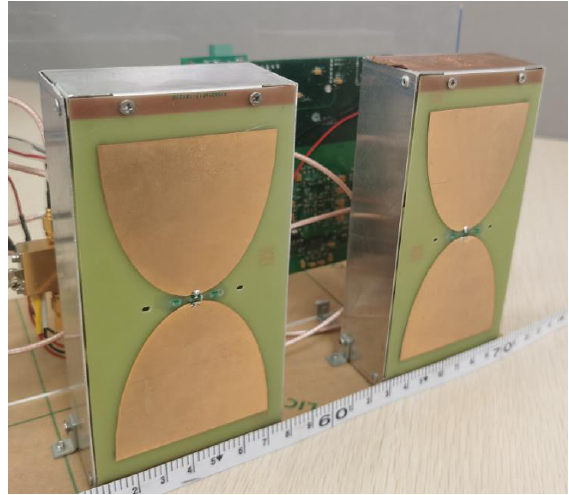
Figure 4. The antennas.